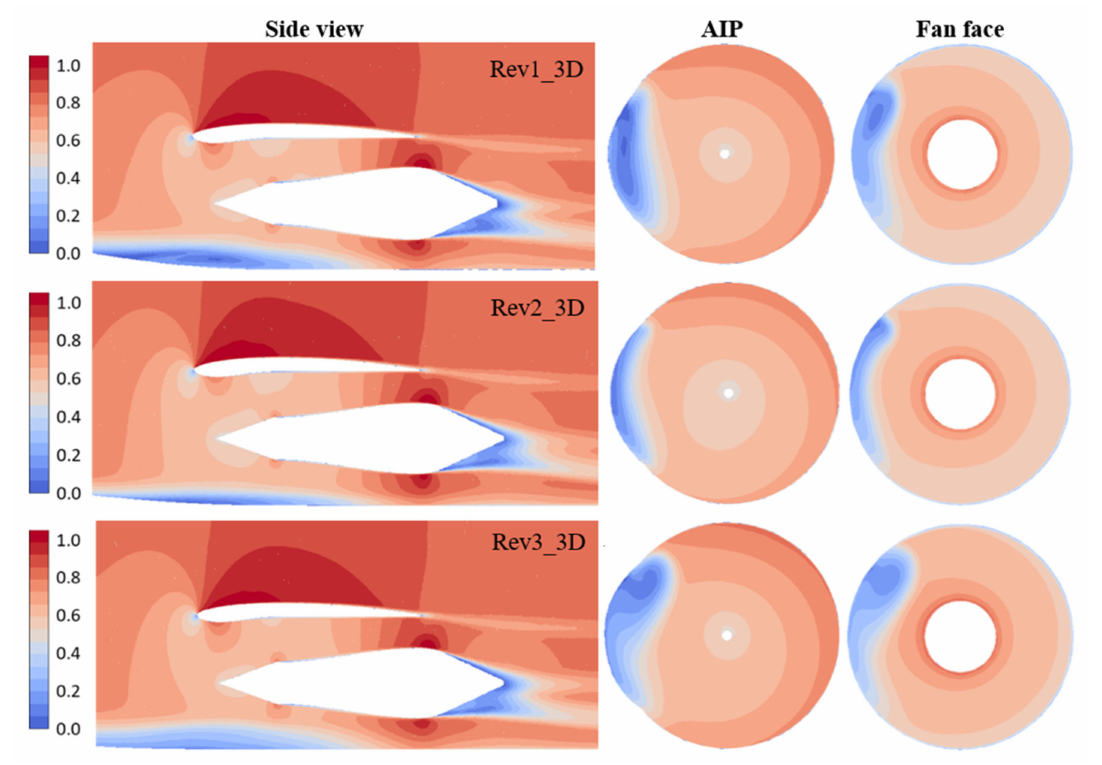
Figure 16. Contours of Mach number in the planes of interest ( from left to right : mid-plane cross- section, AIP and fan inlet), results from the 3D simulation of the three revisions ( from top to bottom : Rev1_3D, Rev2_3D and